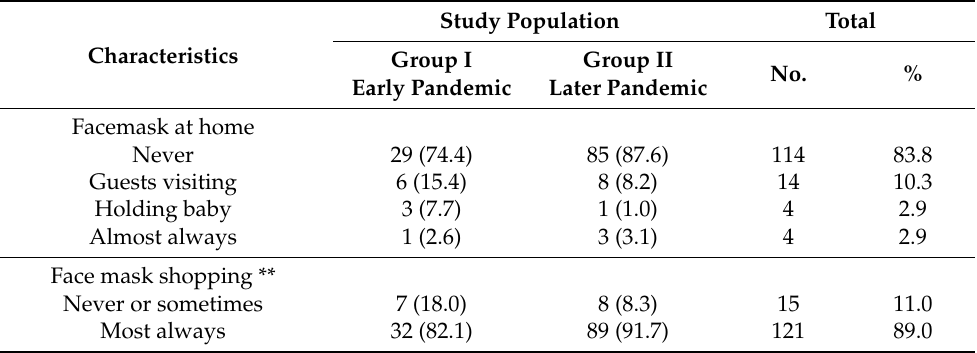
Table 3. COVID-19 breastfeeding safety guideline adherence pattern among mothers during the early and later COVID-19 pandemic